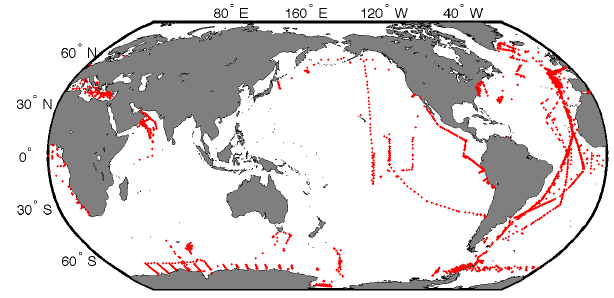
Figure 1. Surface locations of MAREDAT pigment samples that passed quality control (35634 samples).